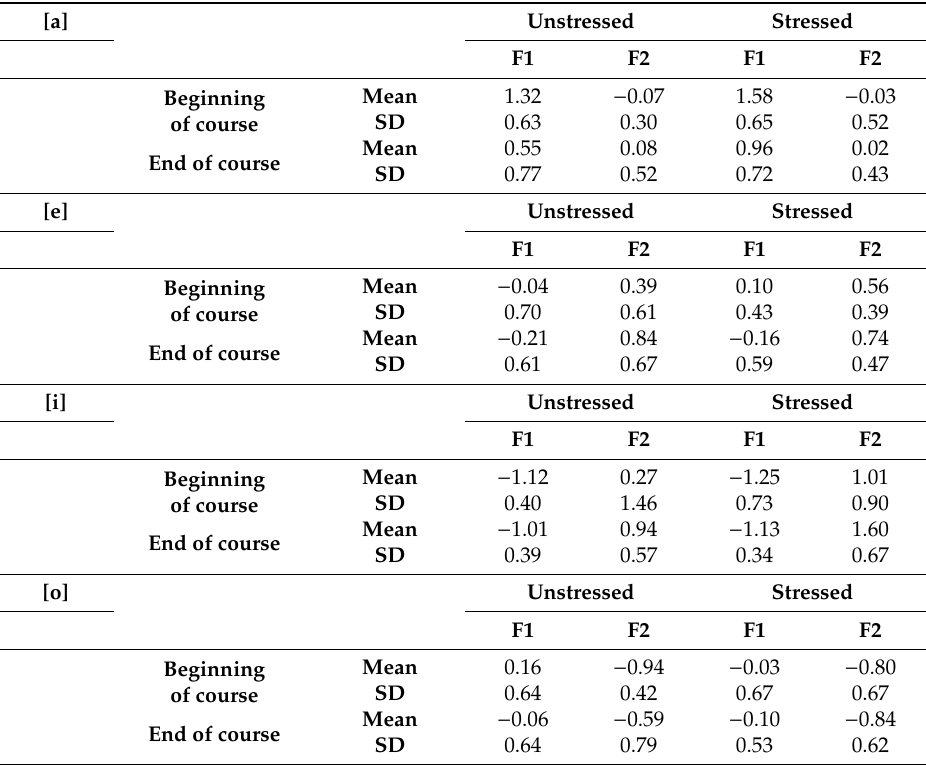
Table 7. Mean Lobanov-normalized F1 and F2 values for Informant